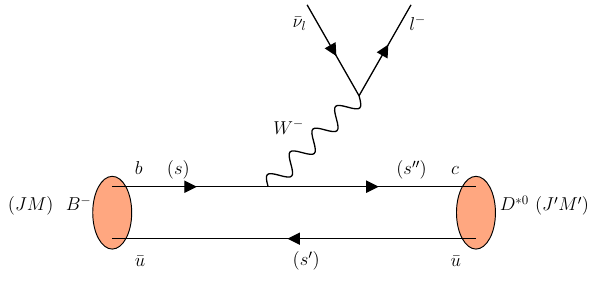
Fig. 1 Diagrammatic representation of B − → D ∗ 0 ¯ ν l l − at the quark level